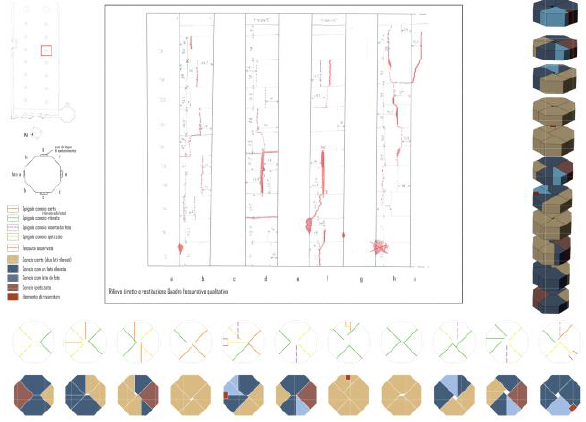
Figure 12. 2D and 3D representations of the columns.